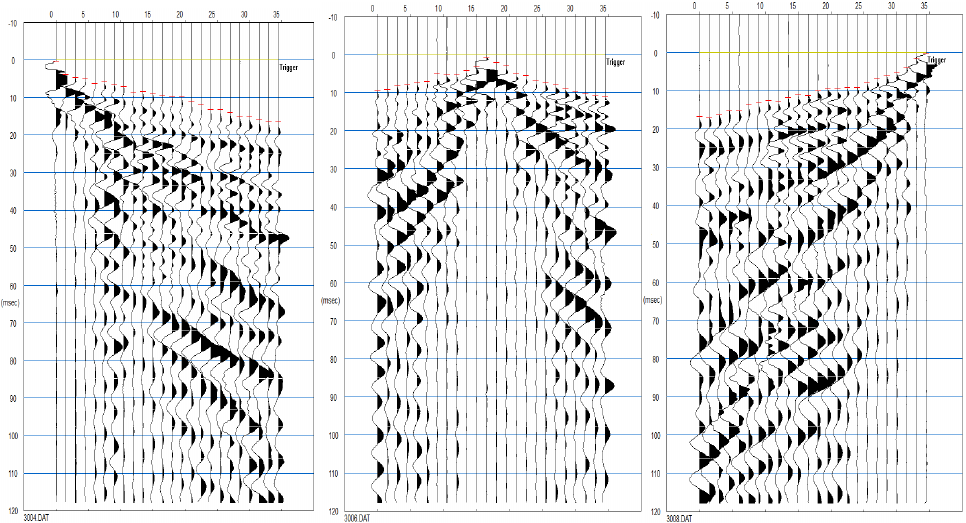
Figure 5. Samples of the shot gathers recorded over the cavity with trace scaling for visibility rea- sons.